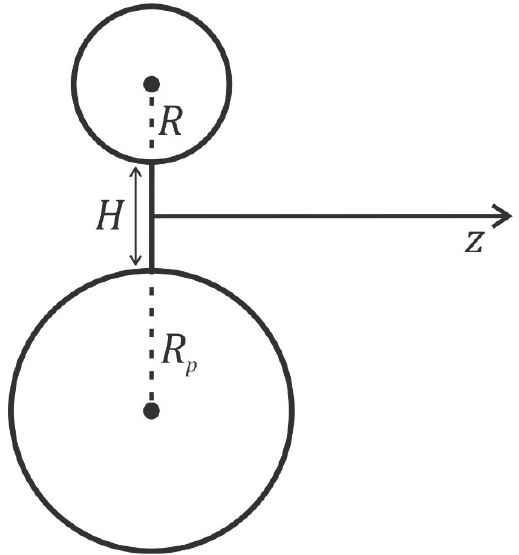
Figure 4. Schematic figure of two electrically charged spheres (vesicles) at the distance H with the radii R p and R